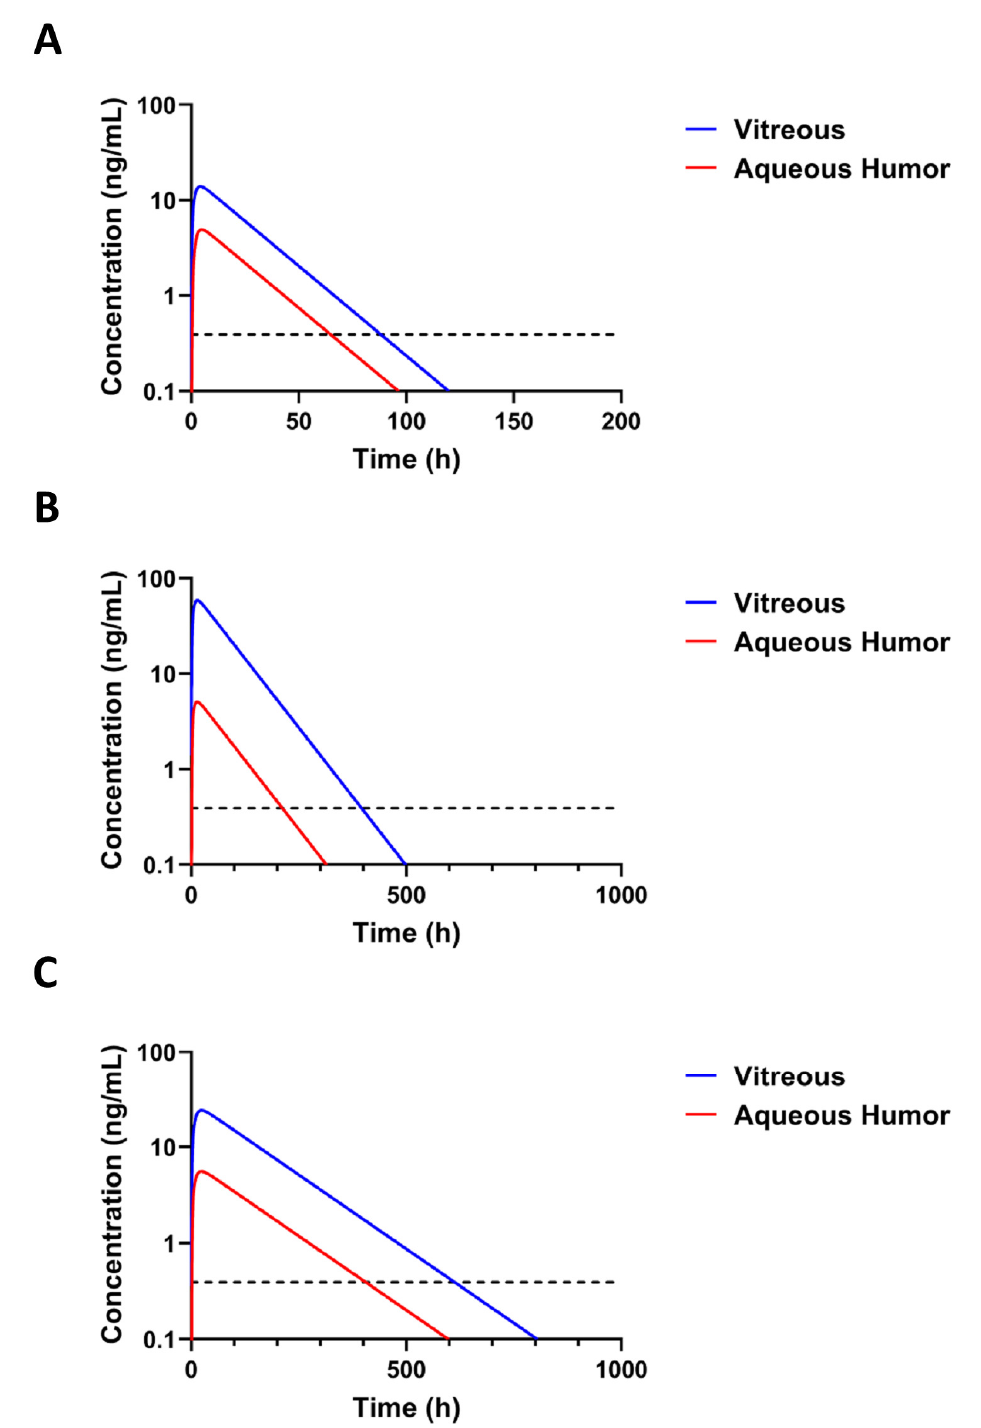
Figure 8. Simulation of released dexamethasone concentration in the vitreous and in the aqueous humor after intravitreal injection of BDP-pullulan-DEX in rat ( A ), rabbit ( B ) and human ( C ). The simulated doses of BDP-pullulan-DEX were 30, 500 and 500 µ g per eye for rats, rabbits and humans, corresponding to DEX doses of 3, 50 and 50 µ g per eye for rats, rabbits and humans, respectively. The dotted line (- - -) shows the minimum effective intravitreal concentration of dexamethasone for inhibiting the expression of VEGF, which is 1 nM (or 0.394 ng/mL) [54].